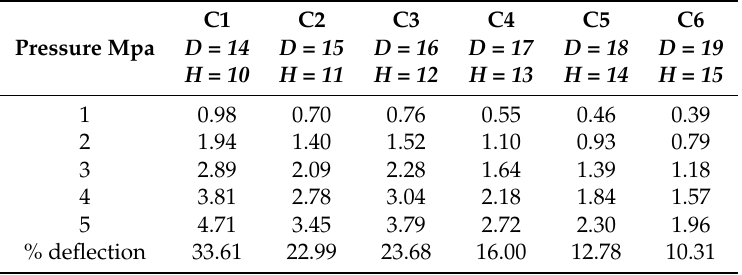
Table 3. Pressure versus center deflection for diaphragms with D and H